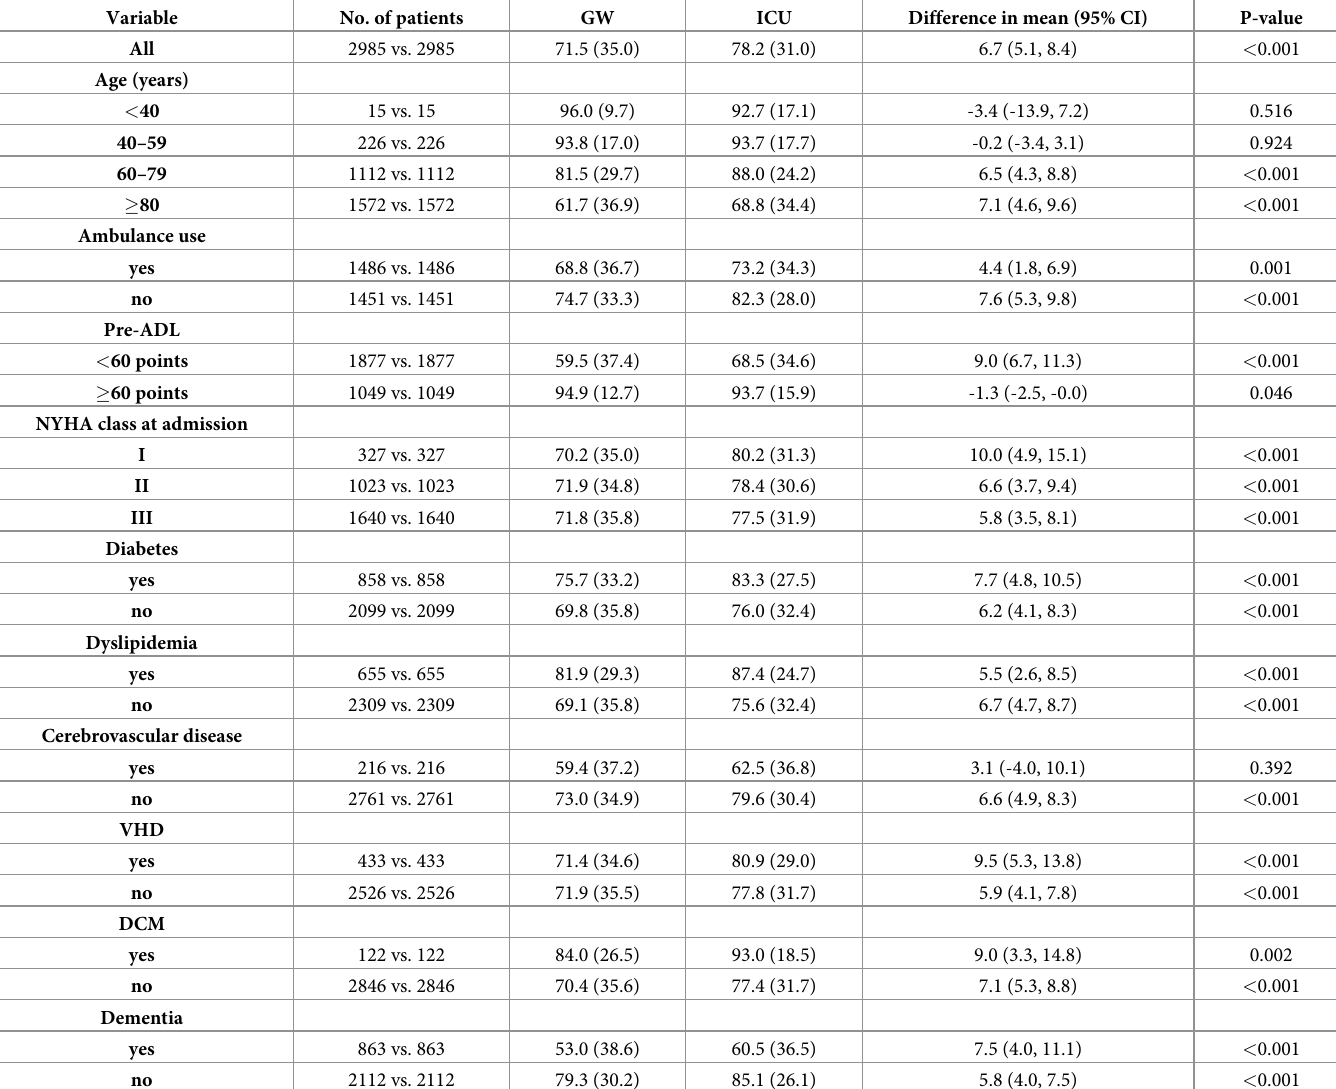
Table 3. Stratified analysis of ADL (Barthel Index) at discharge by age, ambulance use, pre-ADL, NYHA class at admission, diabetes, dyslipidemia, cerebrovascular disease, valvular heart disease, dilated cardiomyopathy, and dementia. Variable No. of